Question: Describe this figure in one sentence.
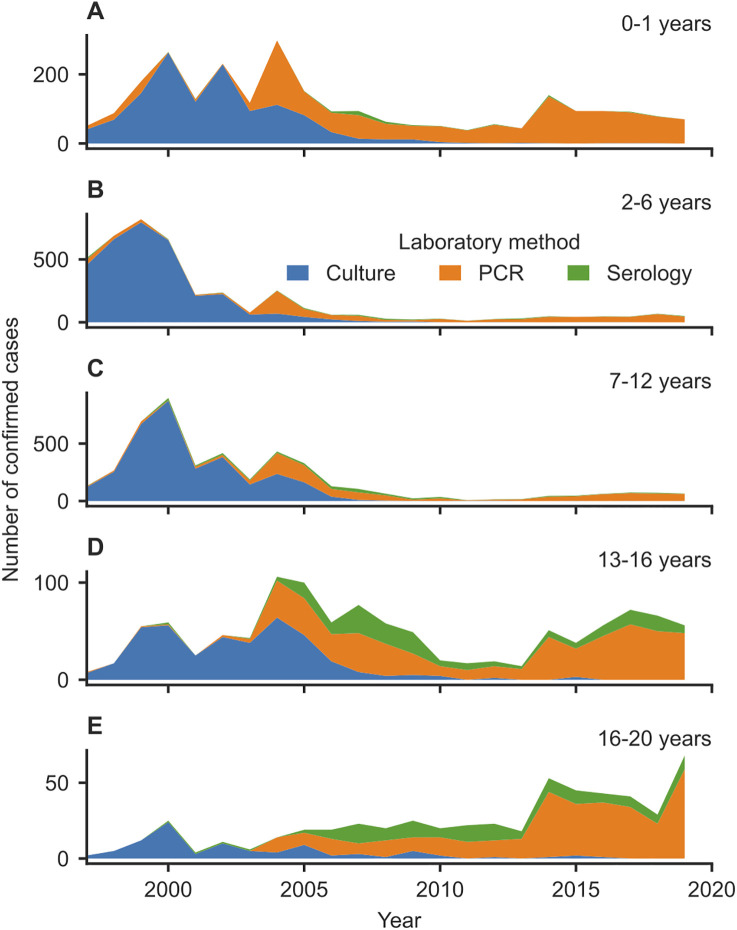
Answer: Annual counts of confirmed pertussis cases by testing method. A–E) Number of annual confirmed cases by method used to confirm the case. Data were available for 5 age groupings: [0, 1] years (panel A), [2, 6) years (panel B), [ 7 , 12 ] years (panel C), [ 13 , 16 ] years (panel D) and [ 16 , 20 ] years (panel E). Data for individuals over 20 years were not available.